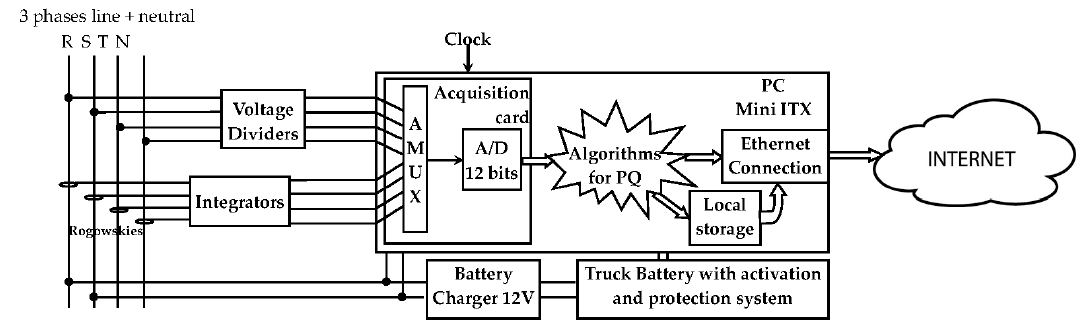
Figure 1. Block scheme of the first version of the instrument for the evaluation of power quality (PQ).PC, personal computer.